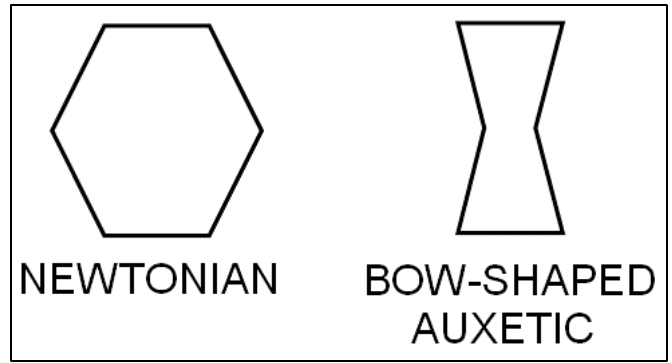
Figure 2. Newtonian and re-entrant (bow-shaped) auxetic cell